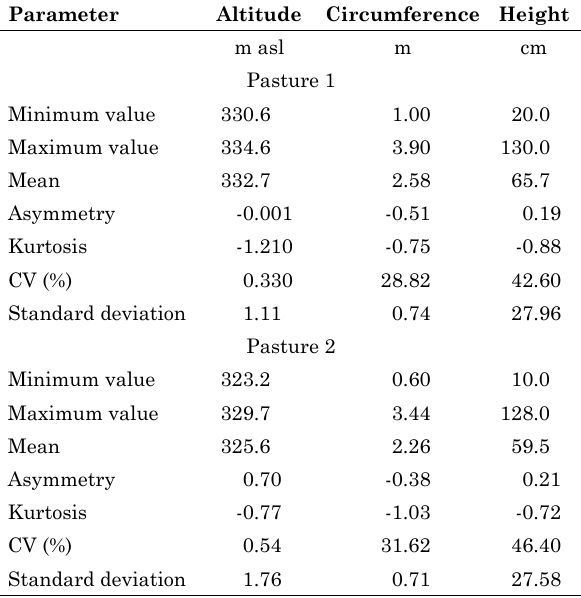
Table 2. Descriptive statistical analysis of data of epigeous termite